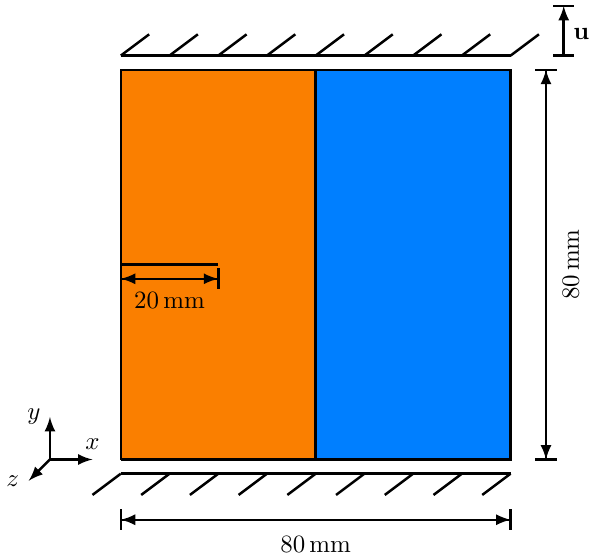
Figure 1. Simulation domain for a crack passing a vertical planar diffuse interface, accompanied by the mechanical boundary conditions. The dotted lines indicate the diffuse transition between the two solid